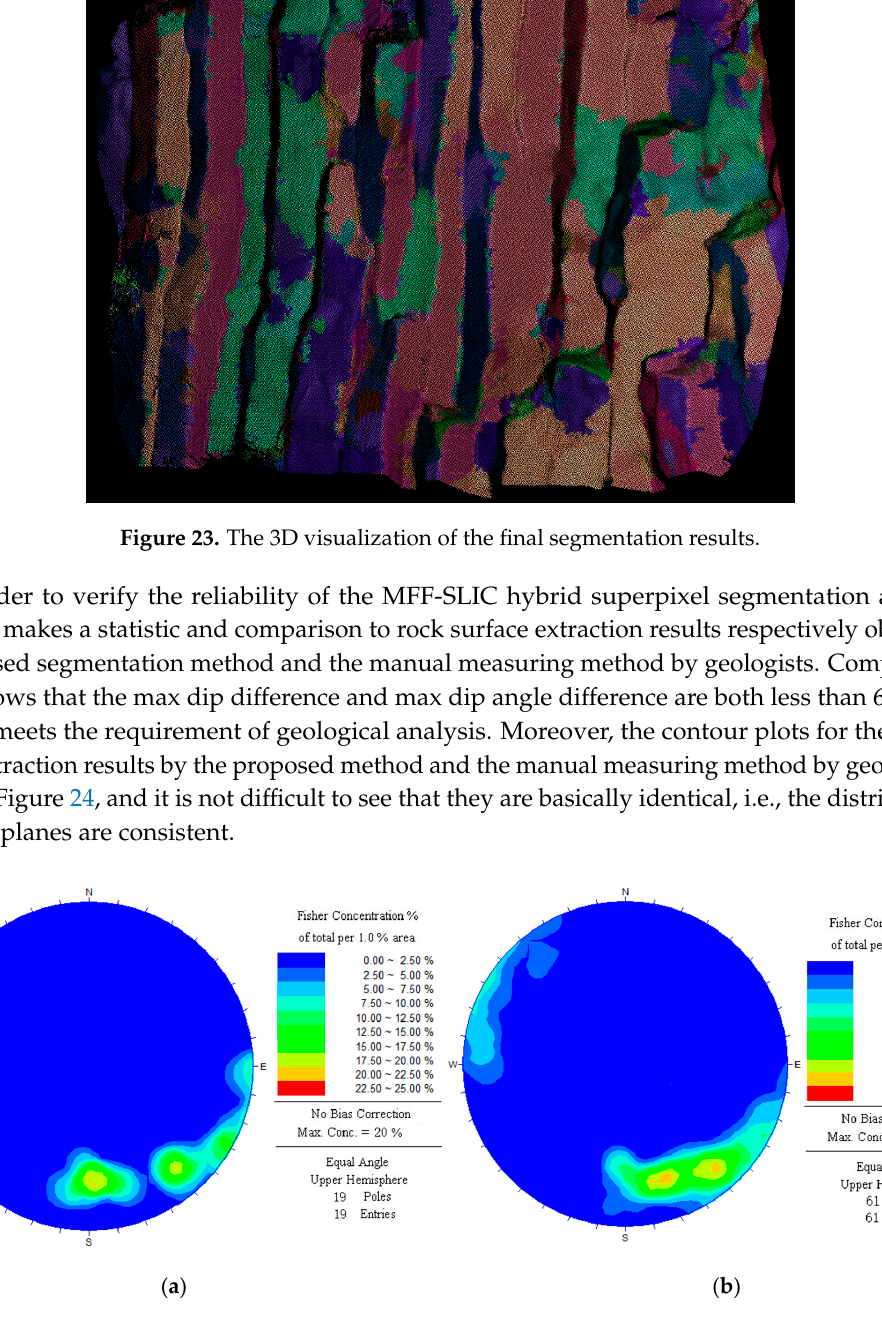
Figure 24. ( a ) The contour plot for structural plane attitudes by the manual measuring method by geologists; and ( b ) the contour plot for structural plane attitudes by the proposed method in this paper.